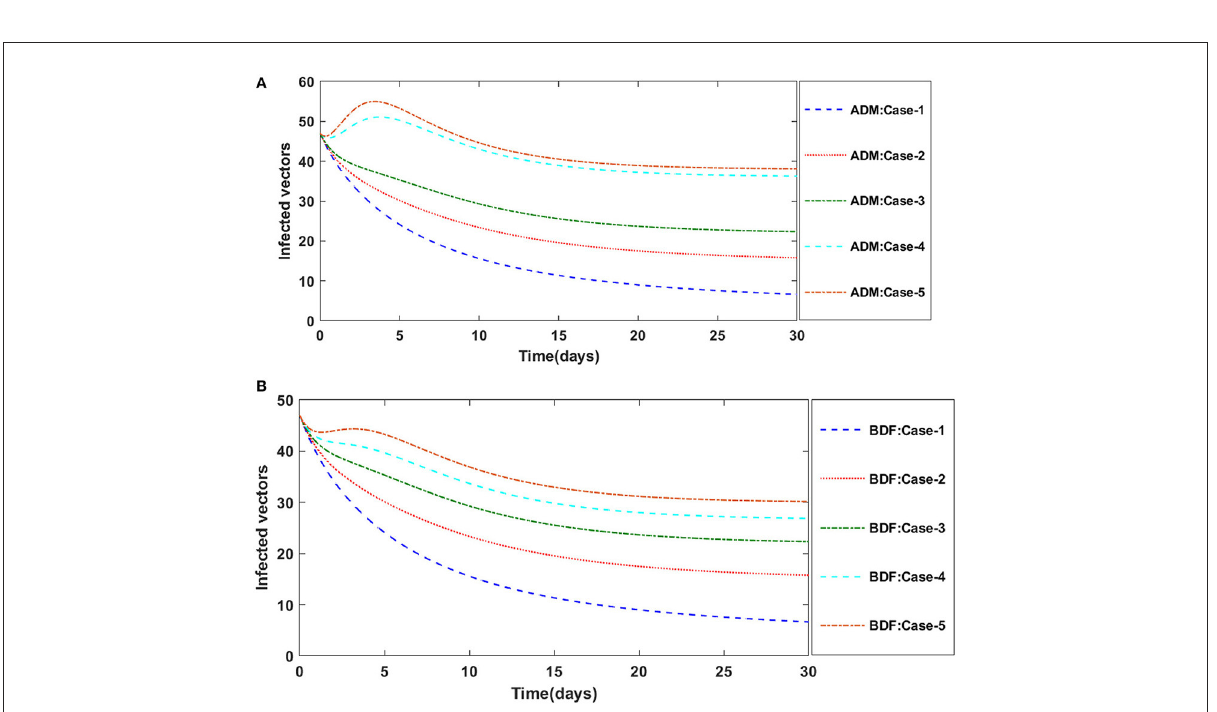
FIGURE5 (A). Dynamics of infected vectors for the varition in γ 1 using ADM for model A. (B) Dynamics of infected vectors for the varition in γ 1 using BDF for model